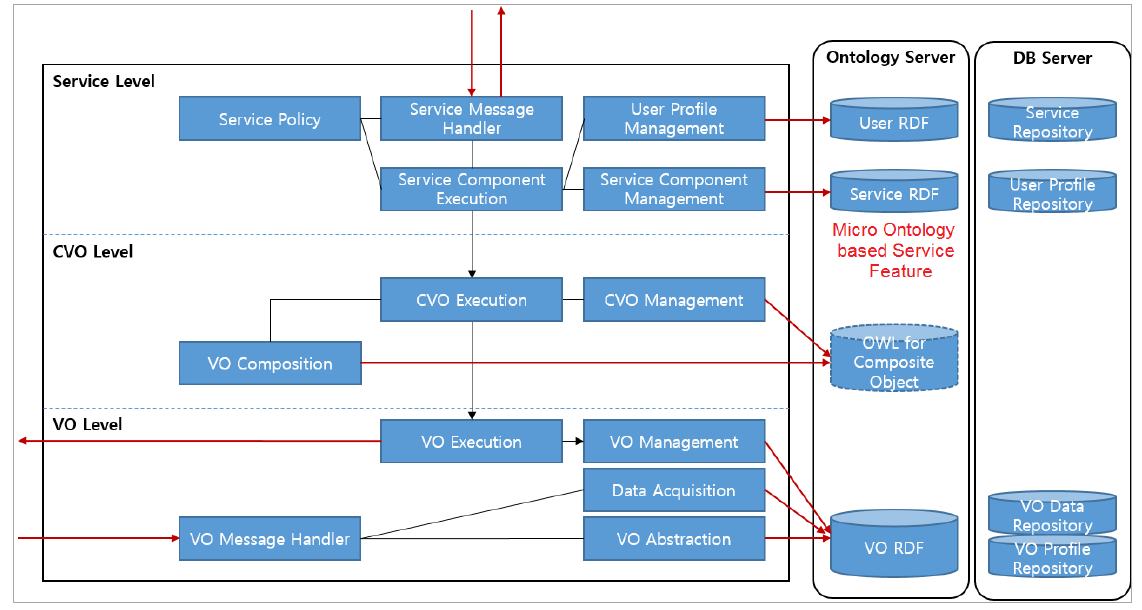
Figure 5. Functional layered architecture of the WoO platform leverages